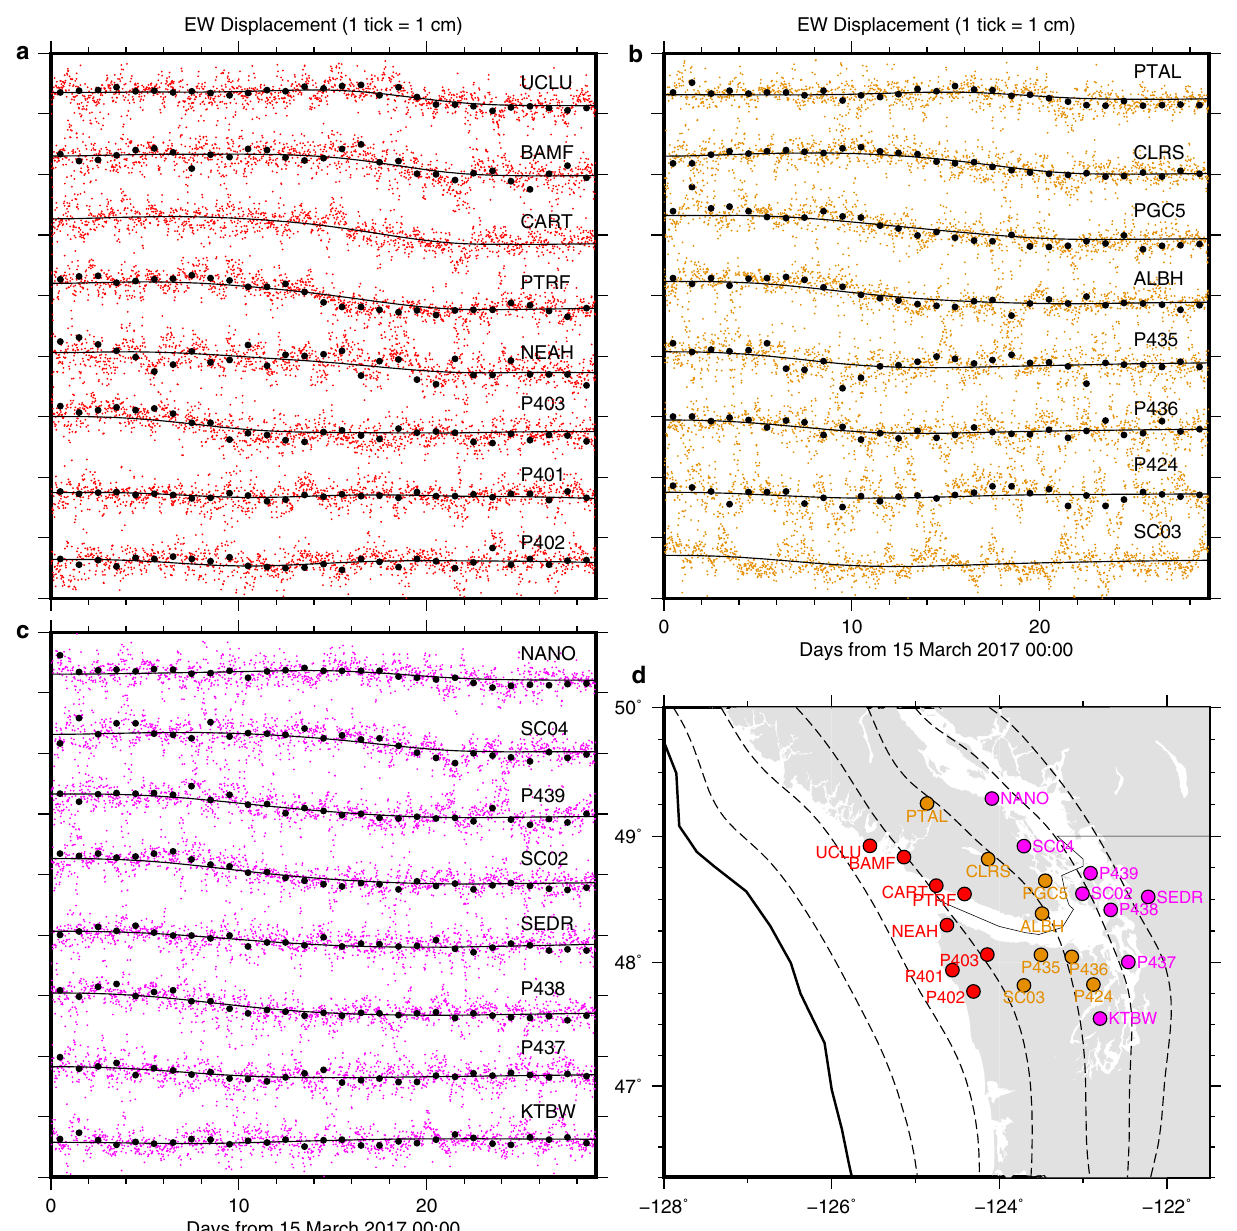
Figure 2. Kinematic GPS data at a 30-min interval and fitting by spatiotemporal slip model. ( a – c ) The coloured dots indicate the post-processed east component of kinematic 30-min GPS positions, further corrected for whole network translation estimated in 30-min slip inversion (see “Methods”). The overlying black dots indicate daily static east component which were corrected for whole network translation estimated in the daily slip inversion (see “Methods”). The daily solutions happen to be unavailable at CART and SC03. The overlying black solid lines indicate the predicted motion due to the fault slip. ( d ) Site location. The coloured circles indicate the site location of the time series with the same colour in ( a – c